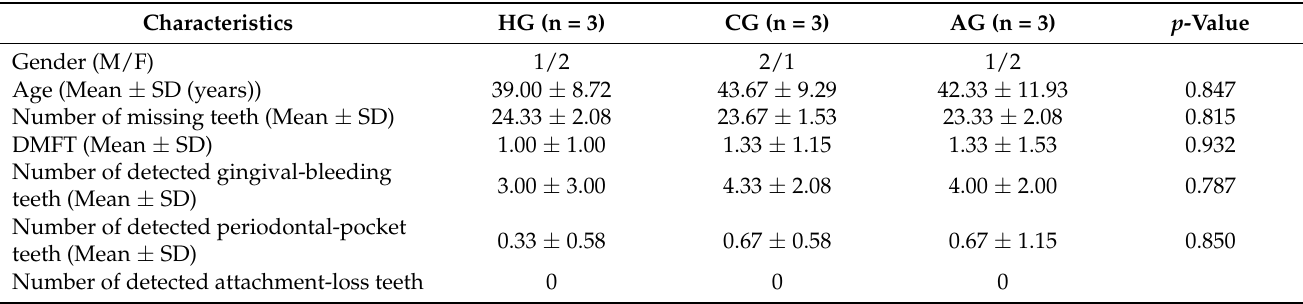
Table S2. Table 1. Demographic and clinical data of HG, CG, and AG.